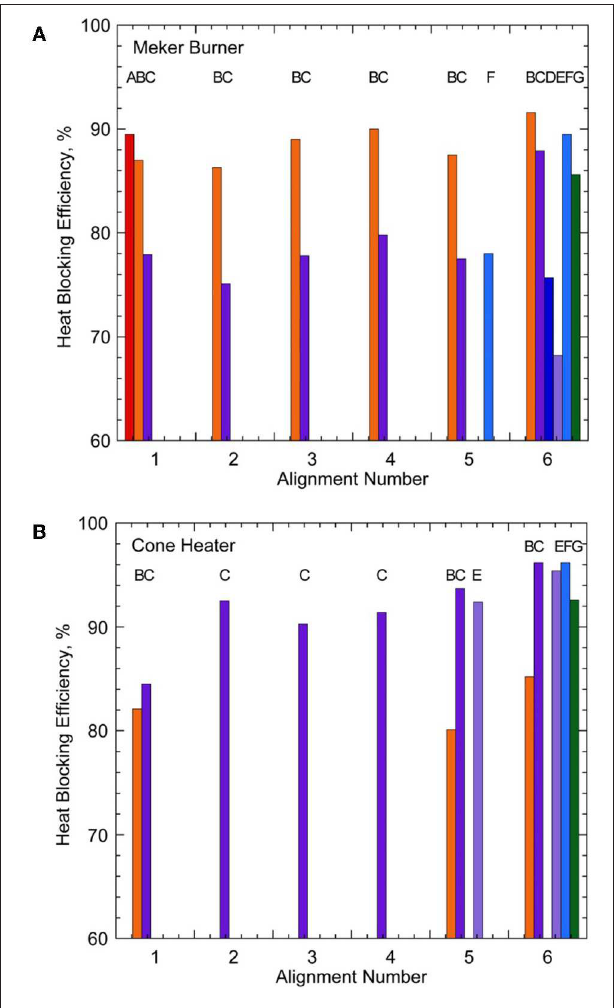
FIGURE 1 | Effects of the layer alignment on the heat-blocking efficiency of double-layered aluminized materials in the (A) Meker burner and (B) cone heater. Assembly number (see Table 3 ), A-aramid/fiberglass, B-aramid/carbon/fiberglass, C, D, E, F-fiberglass, G-fiberglass (inner) and amorphous silica (outer); 1-fabric + fabric (exposed), 2-fabric + fabric/Al (exposed), 3-fabric/Al + fabric (exposed), 4-al/fabric + fabric,